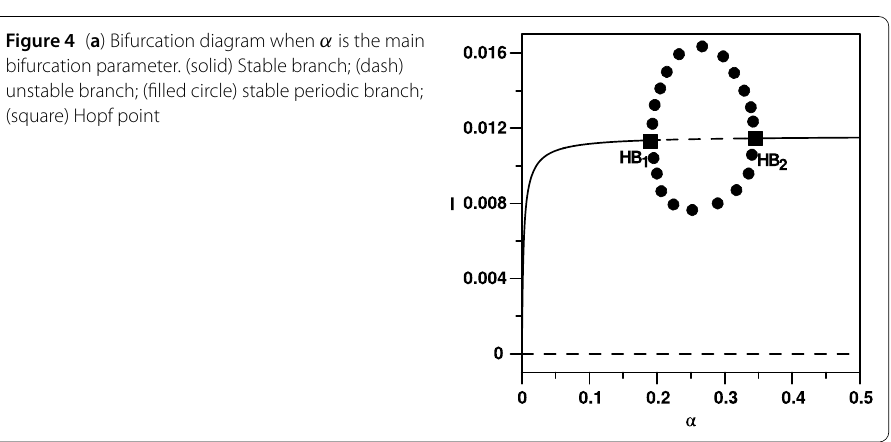
Figure 4 ( a ) Bifurcation diagram when α is the main bifurcation parameter. (solid) Stable branch; (dash) unstable branch; (filled circle) stable periodic branch; (square) Hopf point